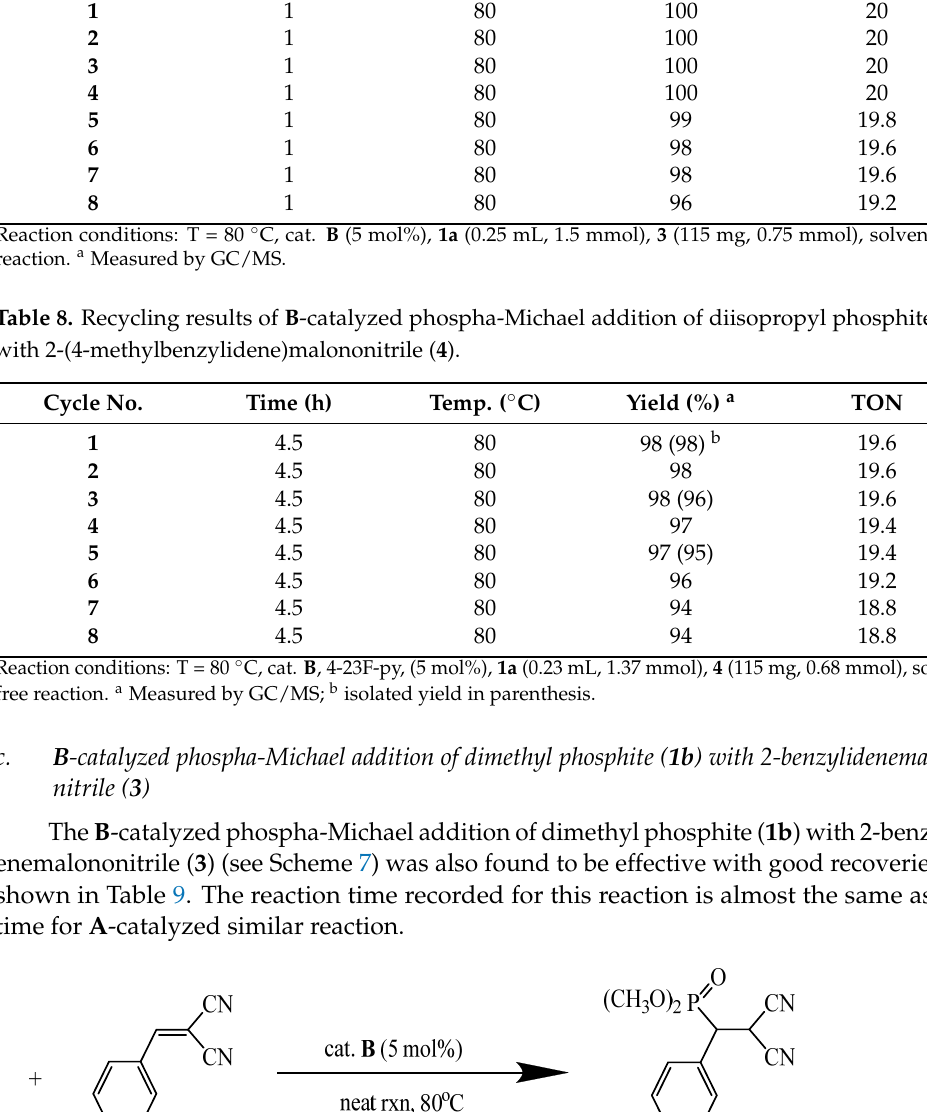
Table 7. Recycling results of B -catalyzed phospha-Michael addition of diisopropyl phosphite ( 1 ) with 2-benzylidenemalononitrile ( 3 ) at 80 ◦ C. Cycle No.